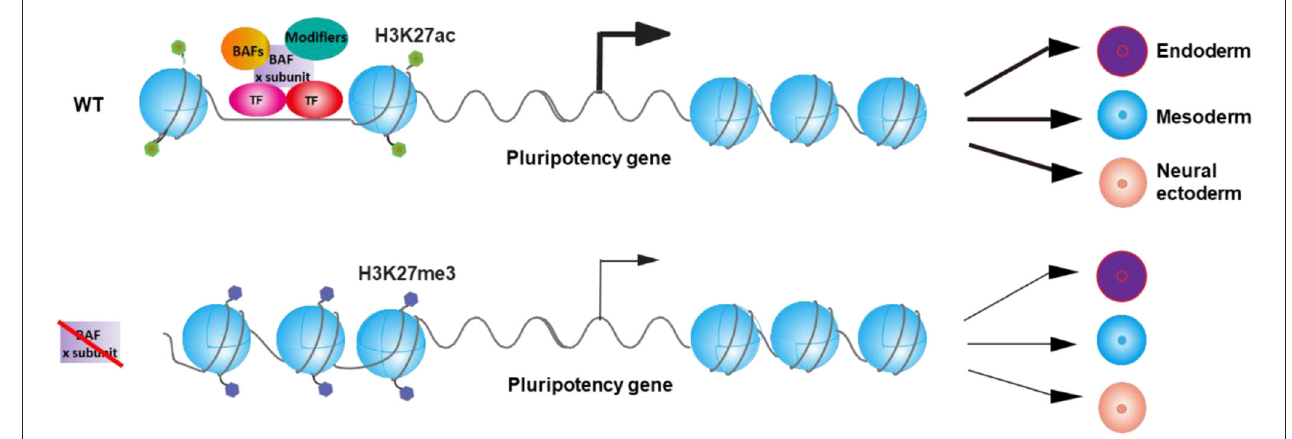
FIGURE 1 | Model for the regulation of the balance between pluripotency and differentiation of embryonic stem cells (ESCs) by BAF complexes via the control of pluripotency gene expression. BAF complex, transcription factors, and other chromatin modifiers regulate the expression of specific pluripotency gene(s) and thereby control the balance between pluripotency and differentiation of ESCs. Inactivation of specific BAF subunit leads to the deregulation of the expression of specific pluripotency gene(s) and therefore results in the differential differentiation defects of ESC.